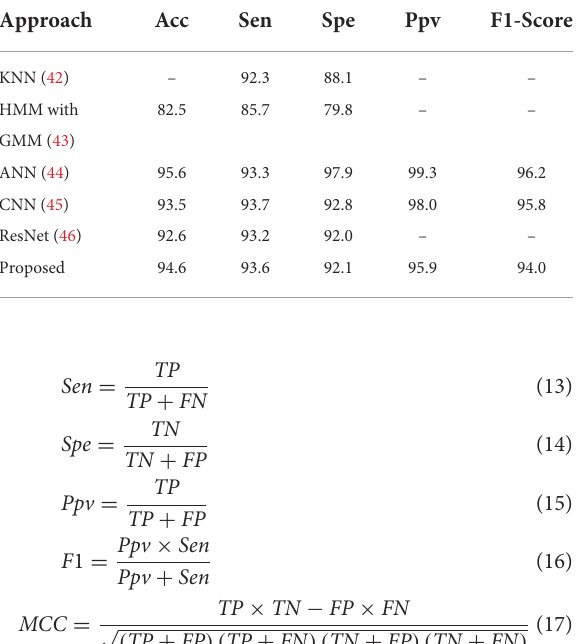
TABLE 4 Classification results of PTB